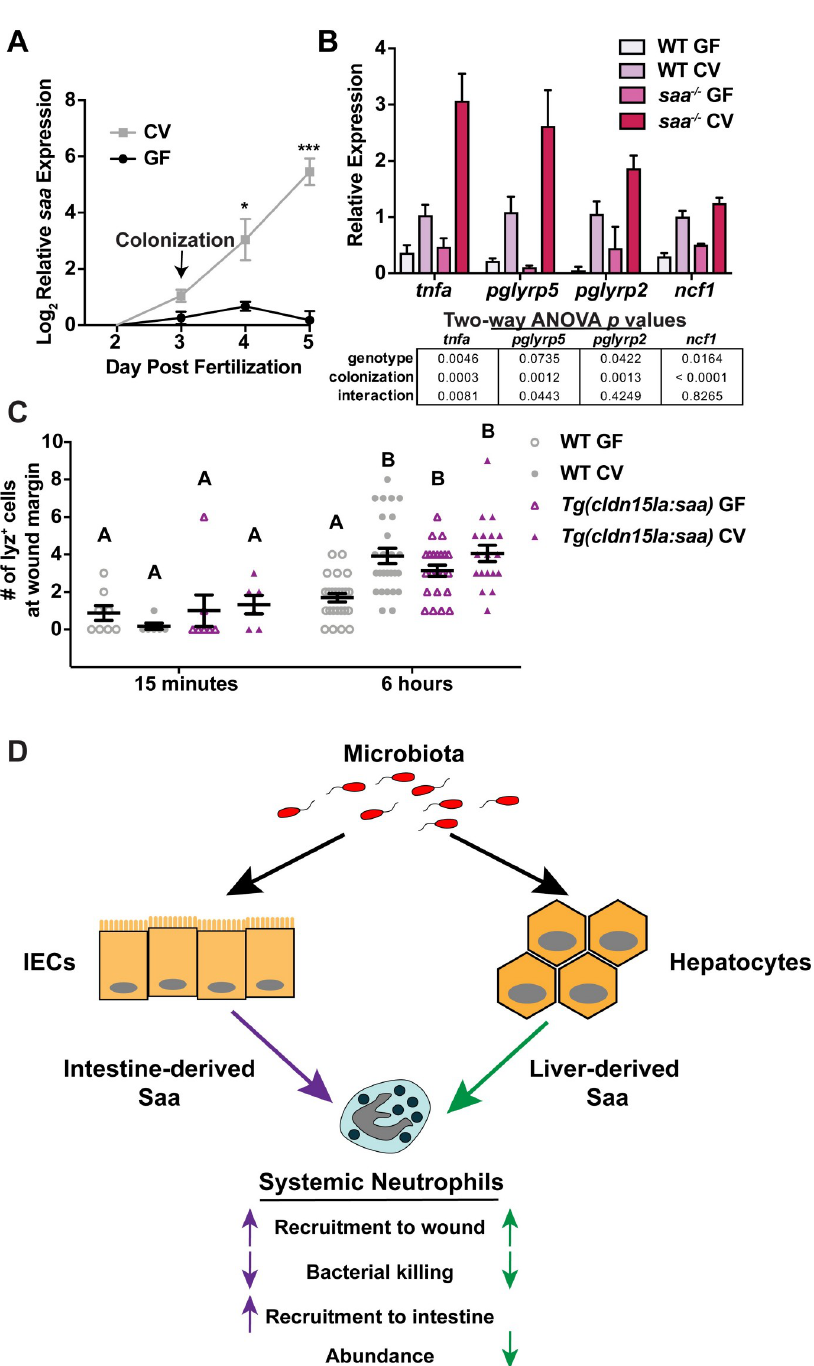
Fig 5. Microbiota-induced Saa conditions neutrophils in vivo . (A) qRT-PCR of saa from gnotobiotic zebrafish larvae following microbiota colonization (CV) at 3 dpf versus germ free (GF) (3 replicates / condition / timepoint, n � 20 larvae / replicate). (B) qRT-PCR of neutrophils isolated from 6 dpf gnotobiotic WT and saa mutant zebrafish larvae (3 replicates / genotype / condition, n � 27 larvae / replicate). (C) lyz:EGFP + neutrophil recruitment to caudal fin wound margin 6 hours after amputation in 6 dpf gnotobiotic WT and Tg(cldn15la : saa) sibling zebrafish larvae (n � 18 larvae / genotype / condition at the 6 hour timepoint). (D) Working model depicting signals from the microbiota evoking production of intestinal and hepatic Saa leading to shared and distinct effects on systemic neutrophil function. Statistical comparisons of data in panel in A were performed within each time point and analyzed by t -test. Data in panel B analyzed by two-way ANOVA with p values reported in the table. Data in panel C analyzed